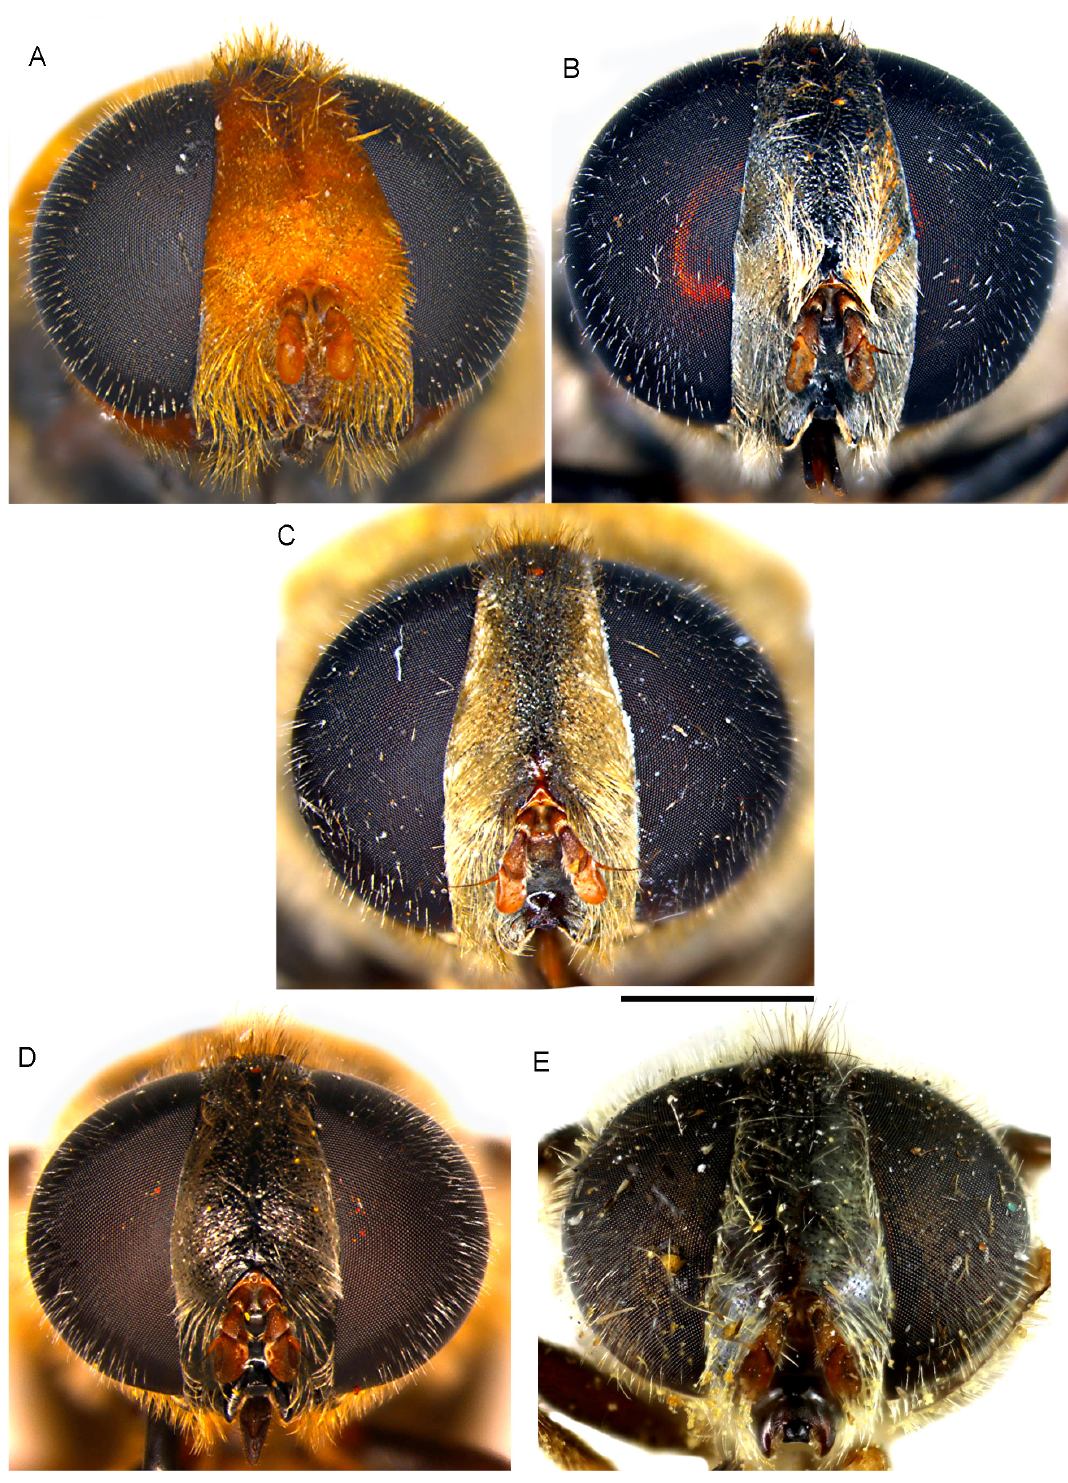
Fig. 15. Female head, frontal view. A . Merodon bombiformis Hull, 1944 (NMSA; FSUNS ID 04278). B . M. multifasciatus Curran, 1939 (FSUNS; FSUNS ID ZA5_243). C . M. zebra Vujić & Radenković sp. nov., paratype (RMCA; FSUNS ID 25090). D . M. lotus Vujić & Radenković sp. nov., paratype (NMSA; FSUNS ID ZA6_067). E . M. nasicus Bezzi, 1915 , lectotype (BMNH; NHMUK010369943). Scale bar = 2